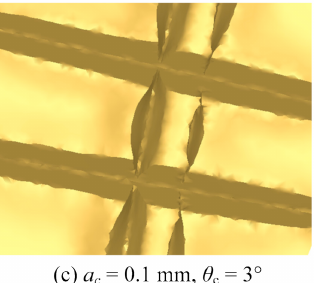
Figure 11. Morphology of microgrooves with di ff erent feeding angles in simulation. ( a ) θ c = 1 ◦ ; ( b ) θ c = 2 ◦ ; ( c ) θ c = 3 ◦ .